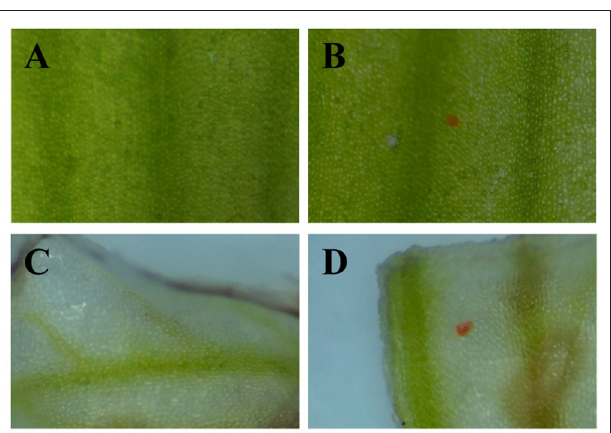
FIGURE 7 | Development of red spots in white petals and lips due to transient expression of CkCHS-1 , CkDFR , and CkANS under the control of the 35S promoter. (A) A petal conducted by particle bombardment with empty vector plasmid. (B) A petal conducted by particle bombardment with the mixture of overexpression vector plasmids of the three genes. (C) A lip conducted by particle bombardment with empty vector plasmid. (D) A lip conducted by particle bombardment with the mixture of overexpression vector plasmids of the three